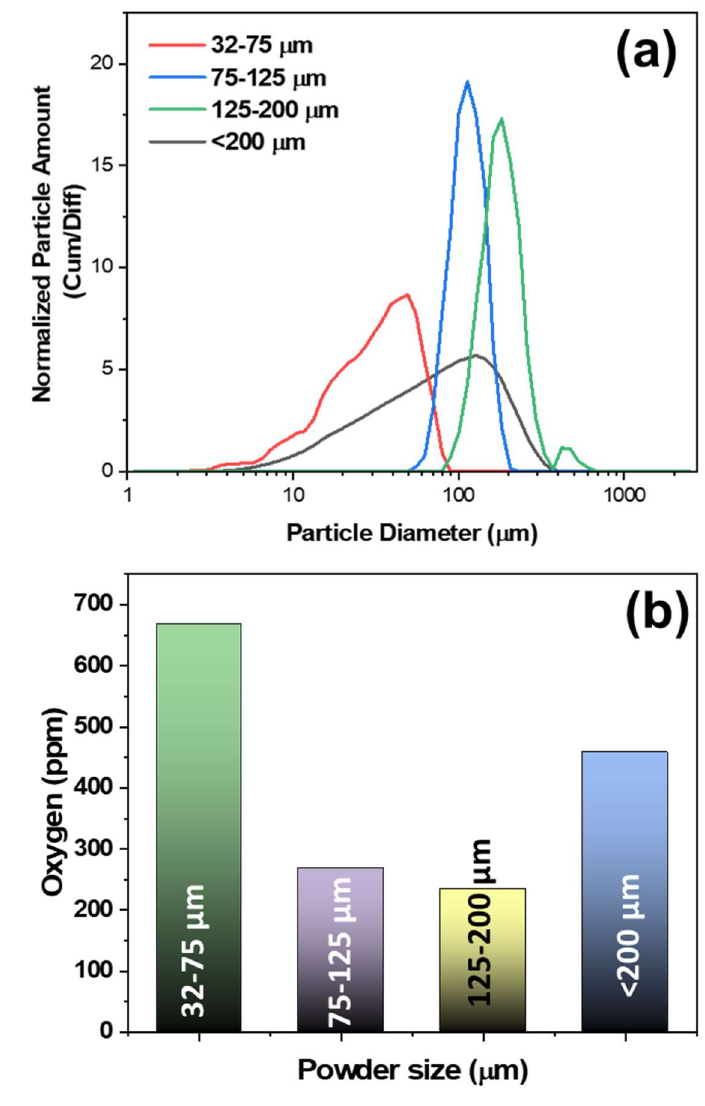
Figure 2. ( a ) Powder size analysis, and ( b ) oxygen contamination analysis of p-type Cu 0.07 Bi 0.5 Sb 1.5 Te 3 ( a ) Powder size analysis, and ( b ) oxygen contamination analysis of p-type water atomized powders. The small powder range (32–75 μm) had the highest content of oxygen Cu 0.07 Bi 0.5 Sb 1.5 Te 3 water atomized powders. The small powder range (32–75 µ m) had the contamination due to the high surface to volume ratio.